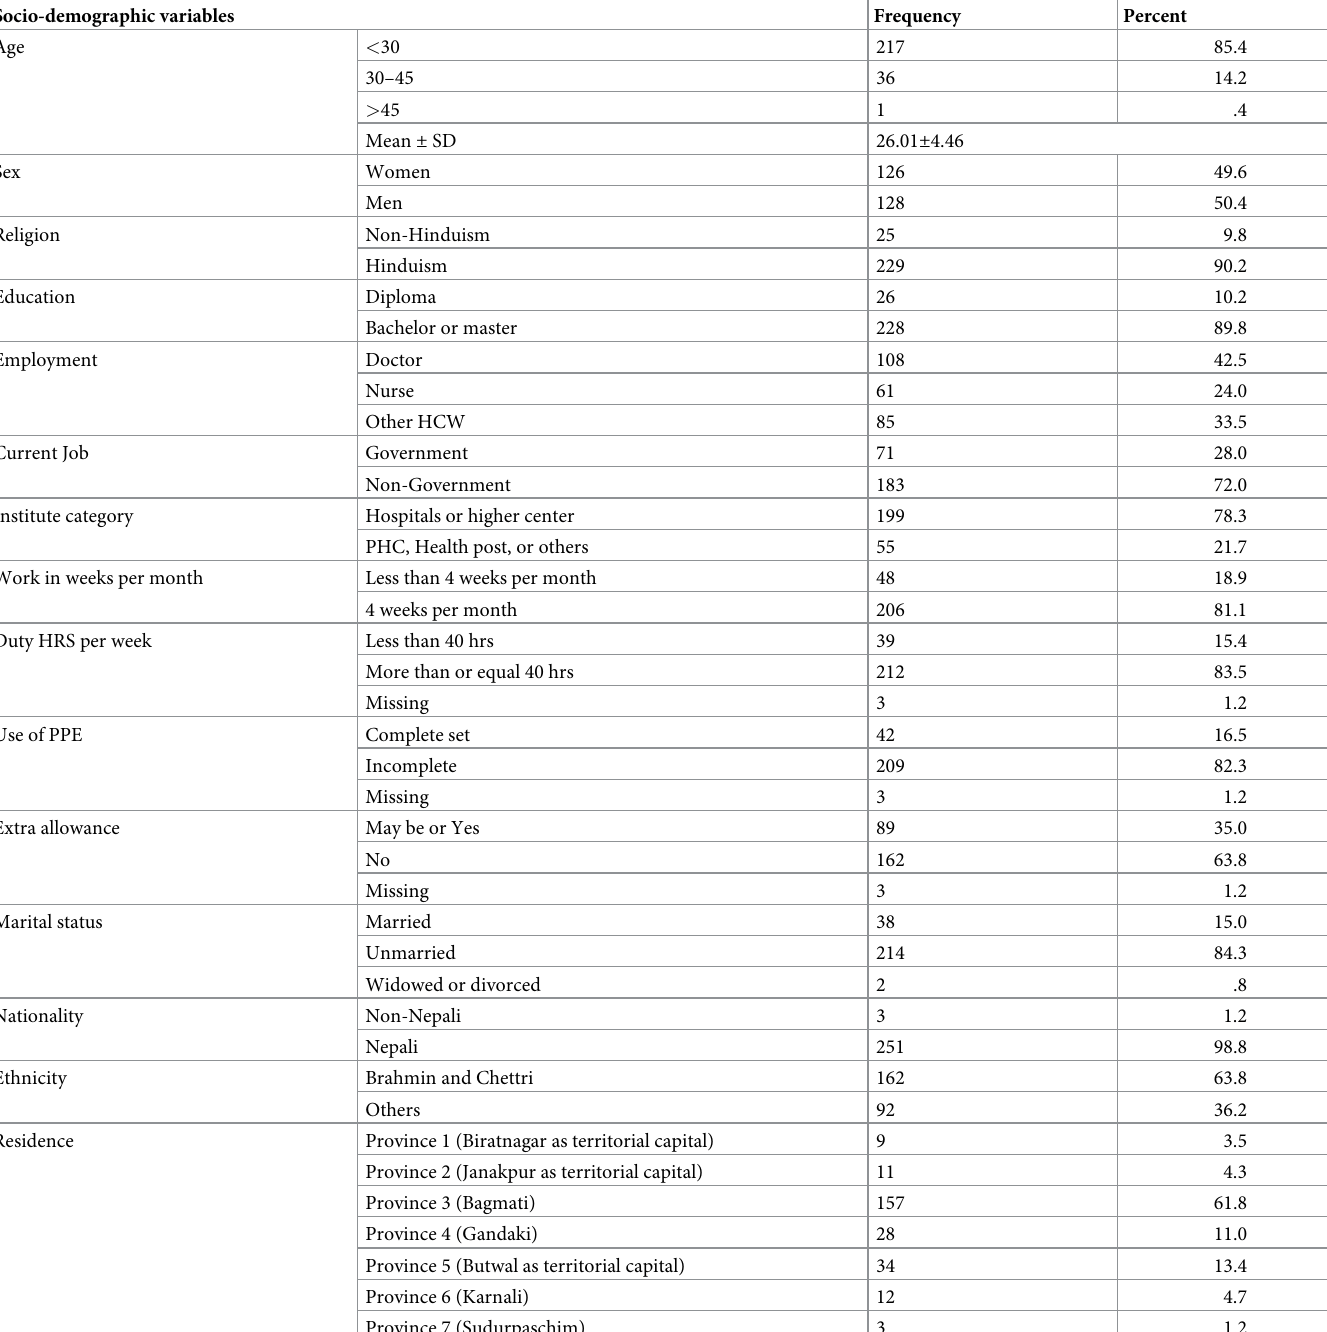
Table 1. Socio-demographic profile of the health care workers (N = 254). Socio-demographic